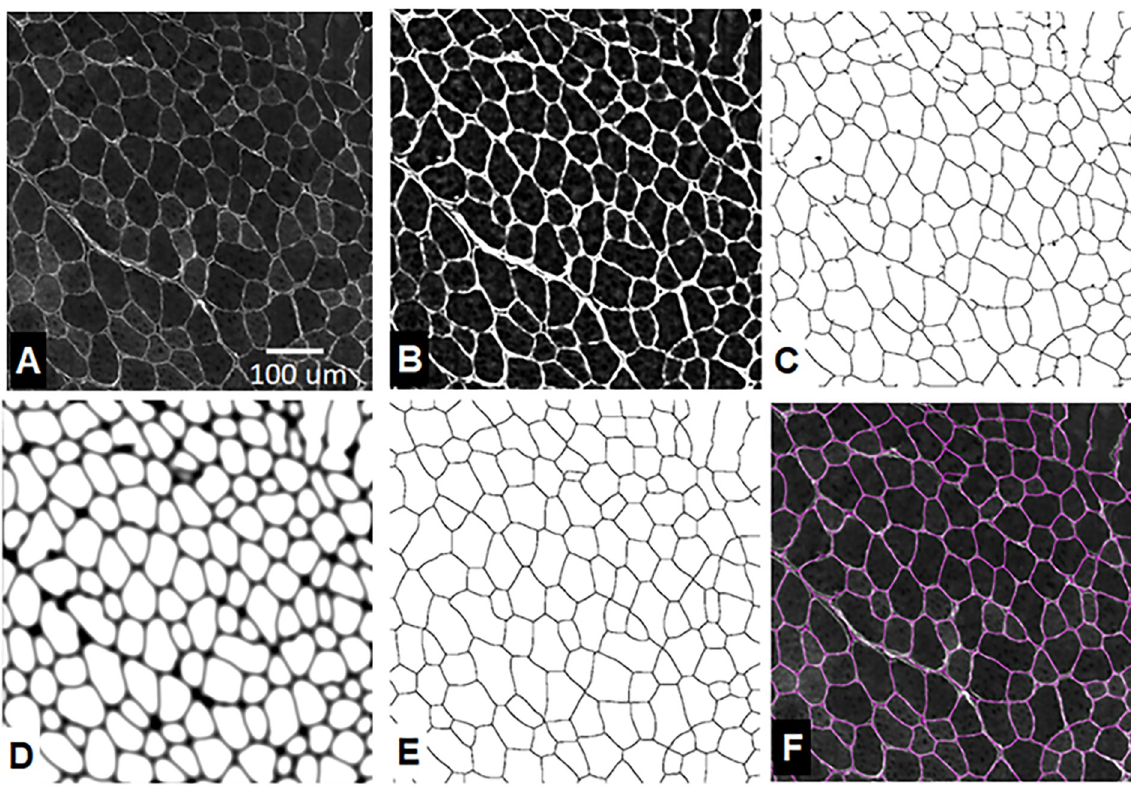
Fig 1. MyoSAT image processing steps: A) Original image. B) Intensity leveling and contrast enhancement. C) Ridge detection. D) Ridge image post-processing. [dilation + Gaussian blur + seed generation] E) Watershed segmentation. F) Result overlay.